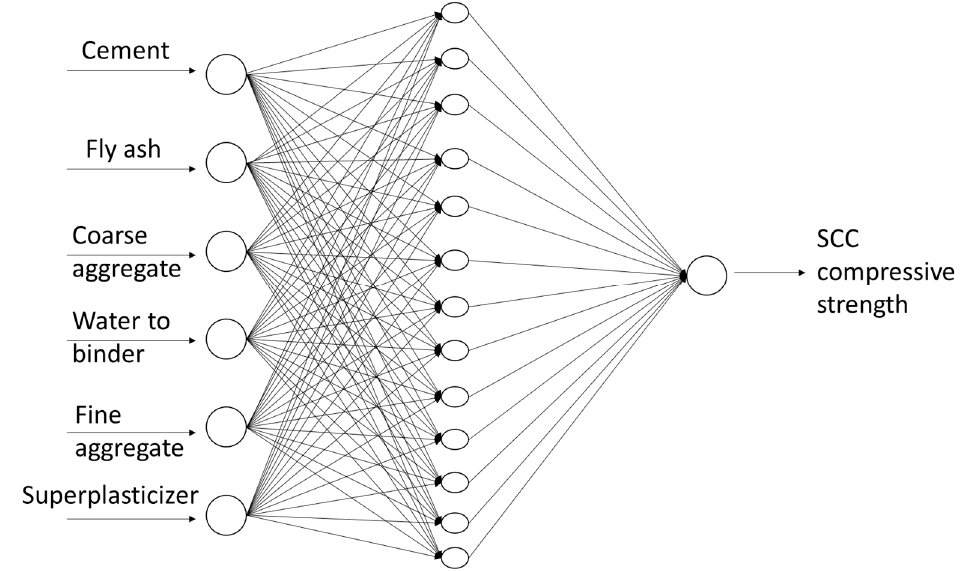
Figure 1. The topology of the neural network used in the study. Table 2. Neural network properties.